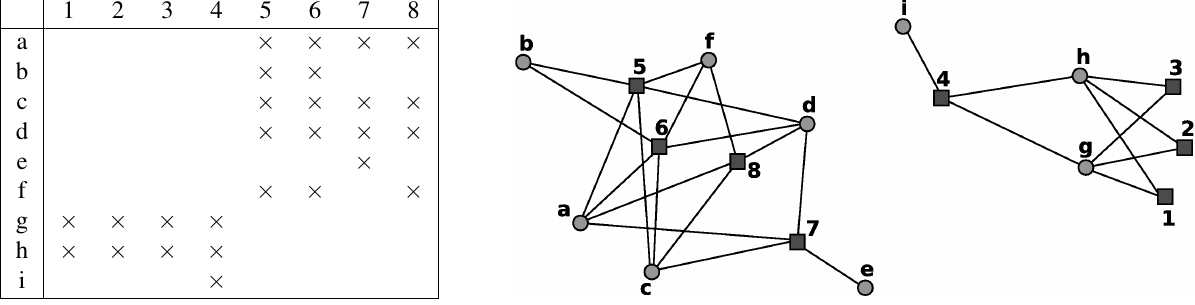
Figure 1: A formal context R and the corresponding bipartite